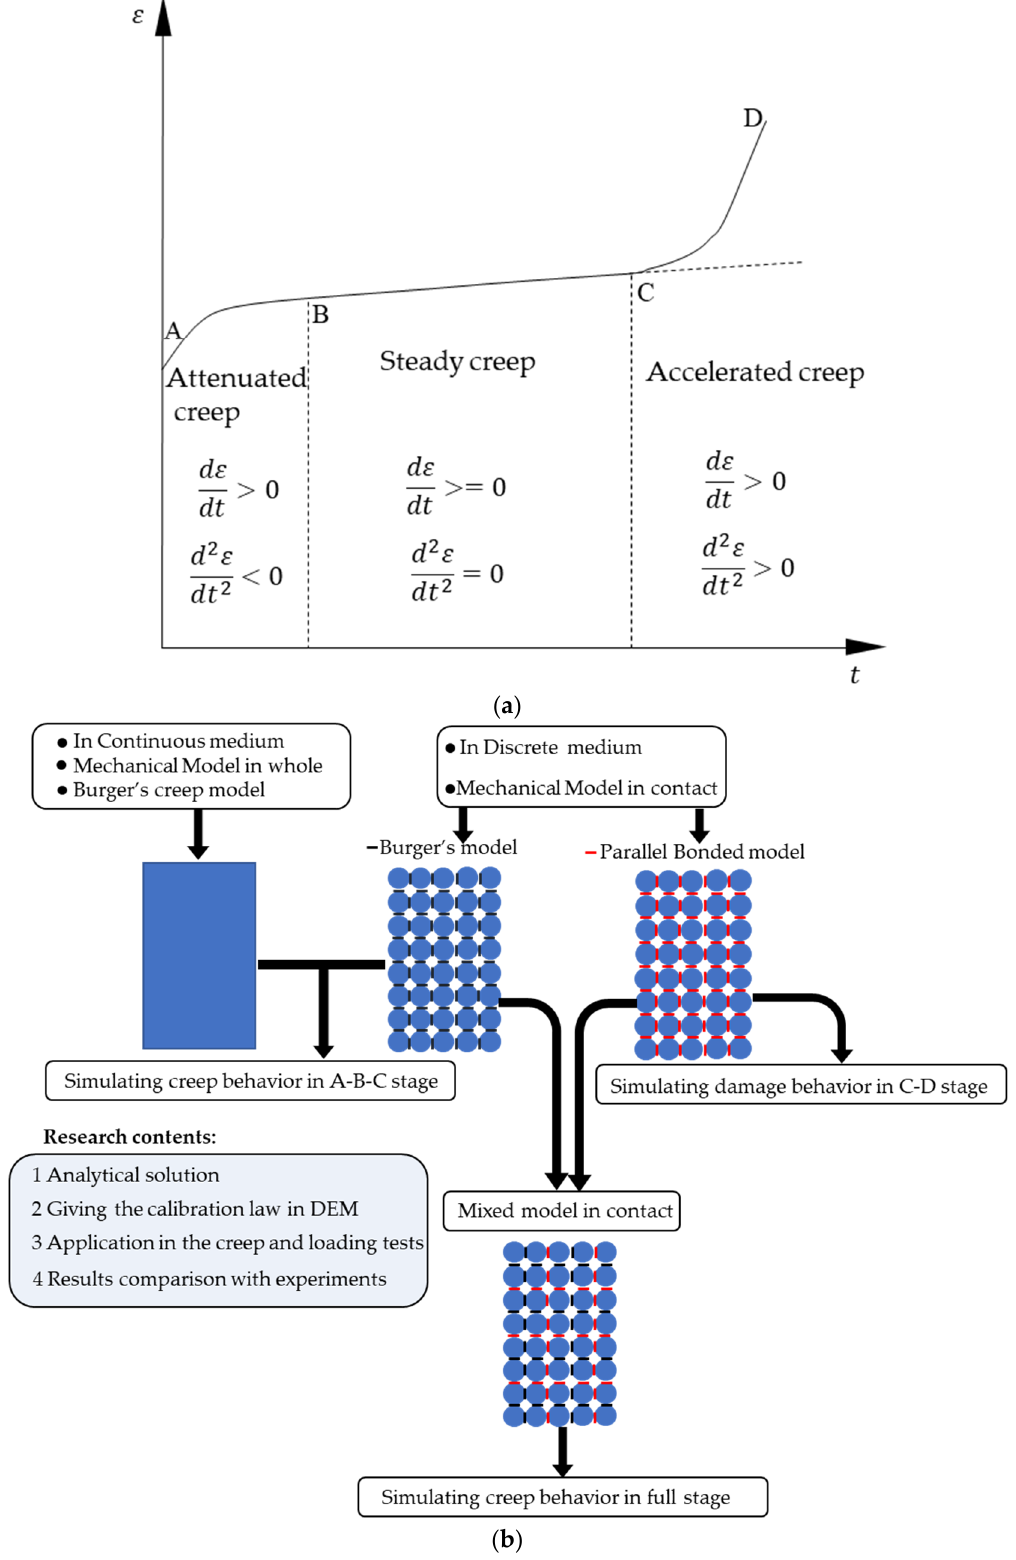
Figure 1. The schematical research process in this paper. ( a ) The full creep stage of soft rock; ( b ) the research contents. In this paper, the mechanism of the Parallel-Bonded model and Burger’s model in DEM are described in detail first. The Parallel Bonded model can simulate the damage process well while Burger’s model can simulate attenuated and steady creep. To mimic